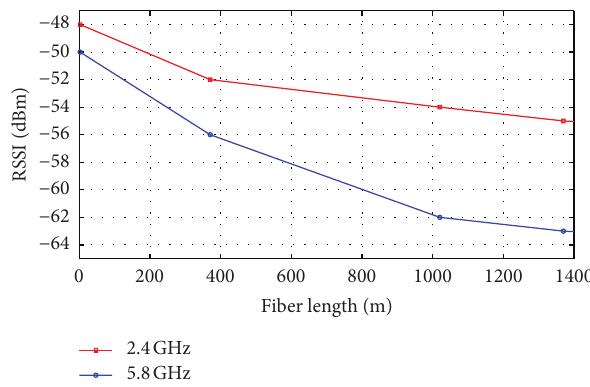
Figure 10: RSSI measurement as a function of the fiber length for the two frequency bands.